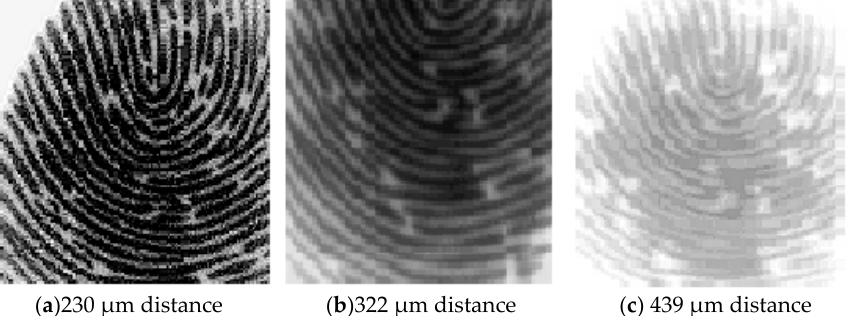
Figure9. Fingerprint sensing result based on electrostatic imaging. Figure 9. Fingerprint sensing result based on electrostatic